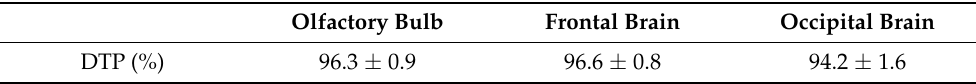
Table 2. Direct transport percentage (DTP) of each brain